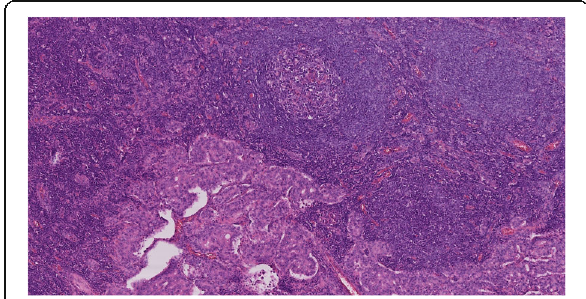
Fig. 5 Histopathology - lymph node with a metastasis of NET, HE staining,